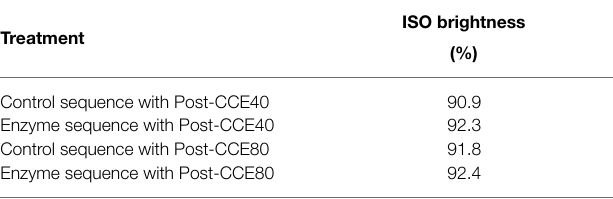
TABLE 4 | ISO brightness of eucalyptus kraft dissolving pulp treated with the sequence O-X 0 -D 0 -HCE-X 1 -HCE-D 1